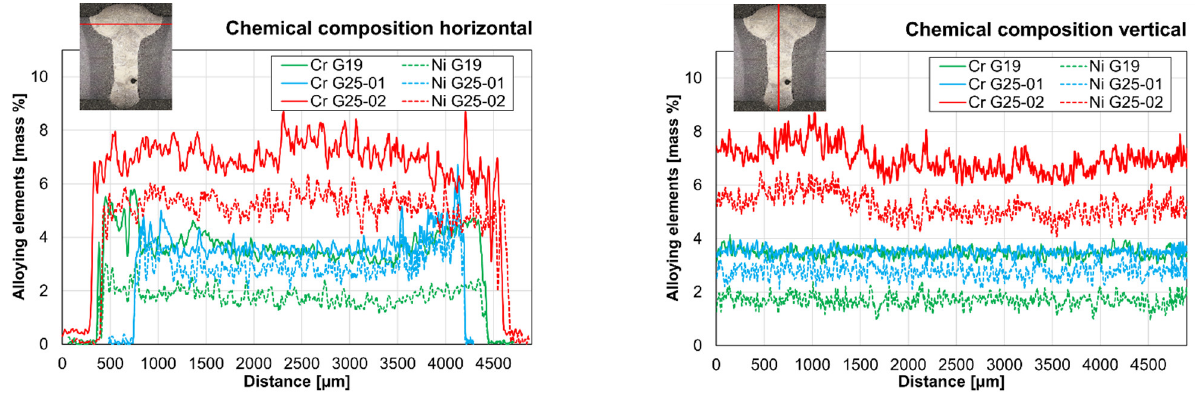
Figure 2. Chemical composition of the welds showing fluctuations in Cr- and Ni content in the outer regions of the dissimilar weld seams. ( left ) Chemical composition horizontal, ( right ) chemical com- position vertical. Table 3. Mean chemical composition of the dissimilar welds.